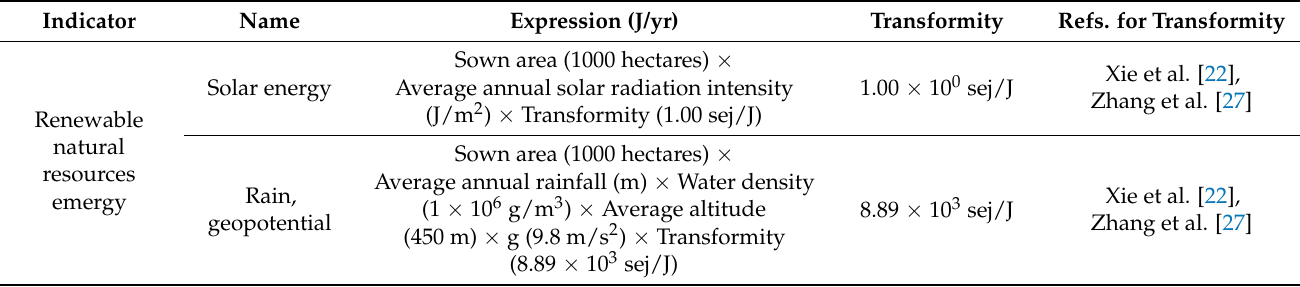
Table 2. Emergy transformity of China’s